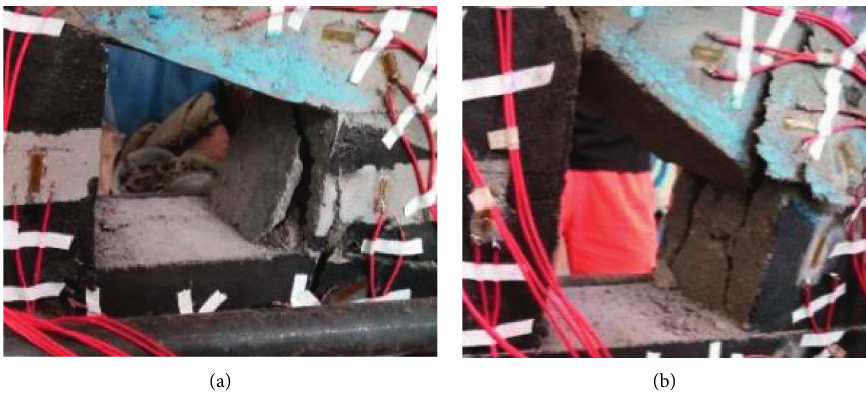
Figure 16: Deformation and failure of roadway in laboratory model test. (a) 24 ° . (b) 27 ° .